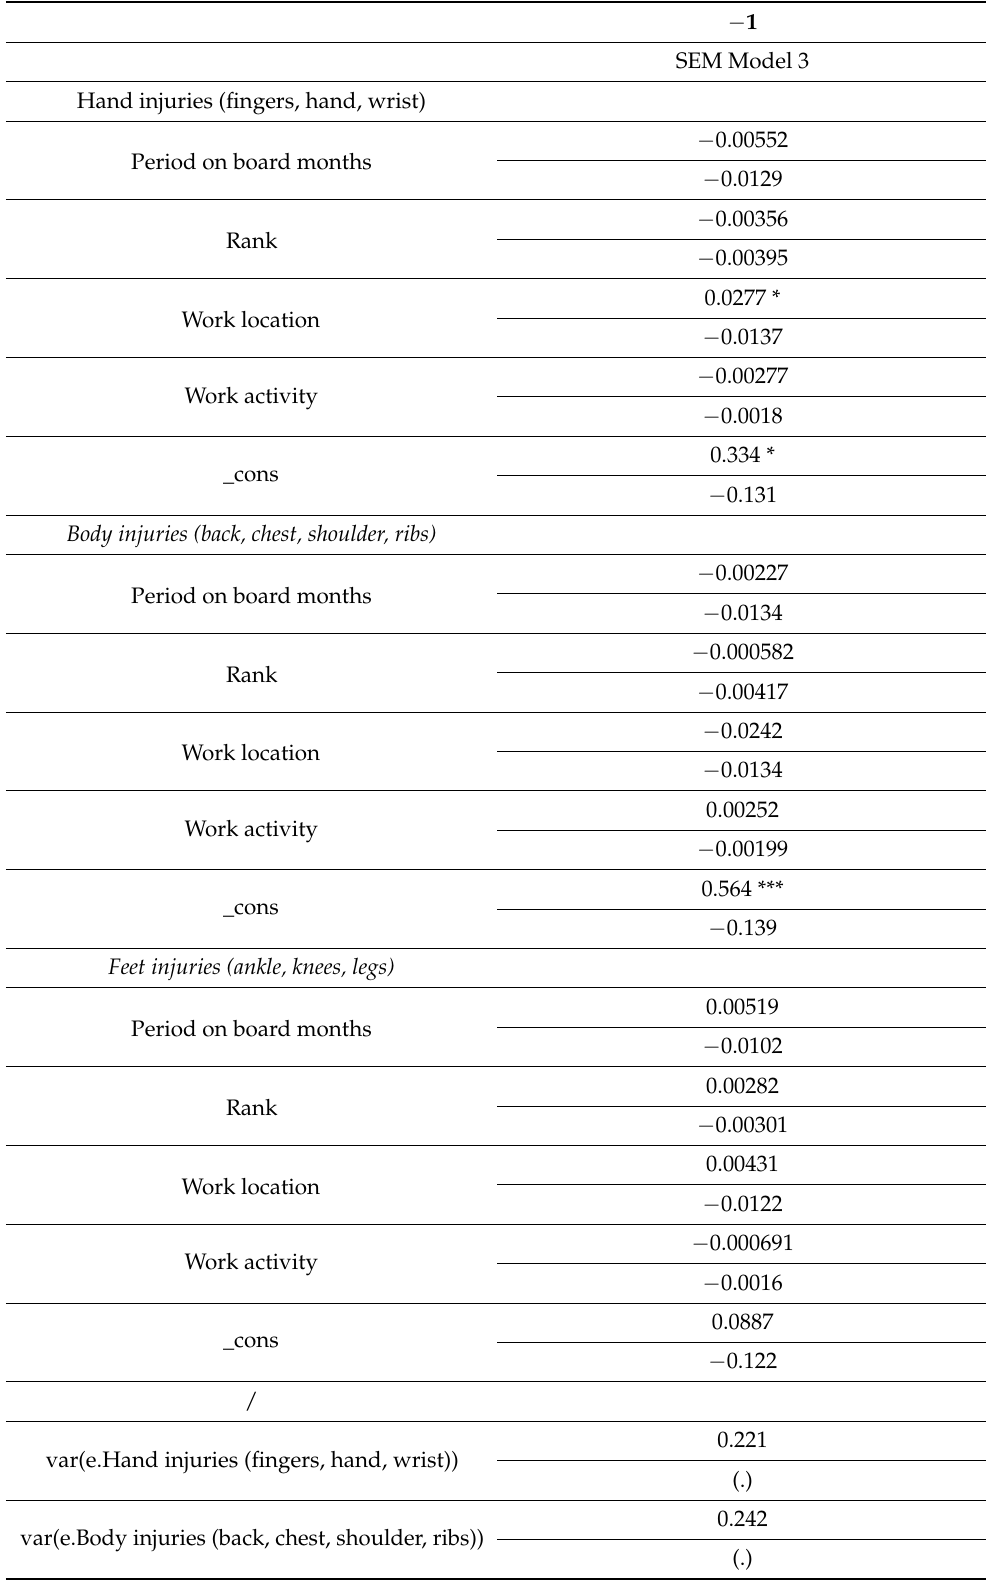
Table 6. Detailed results of SEM 3—third model of structural equation